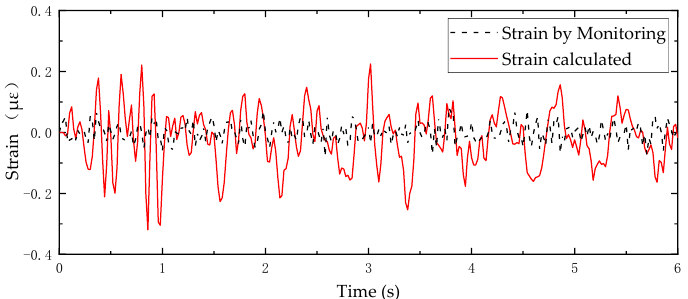
Figure 20. Comparison of dynamic strain between measurement and simulation results of DSS-14.